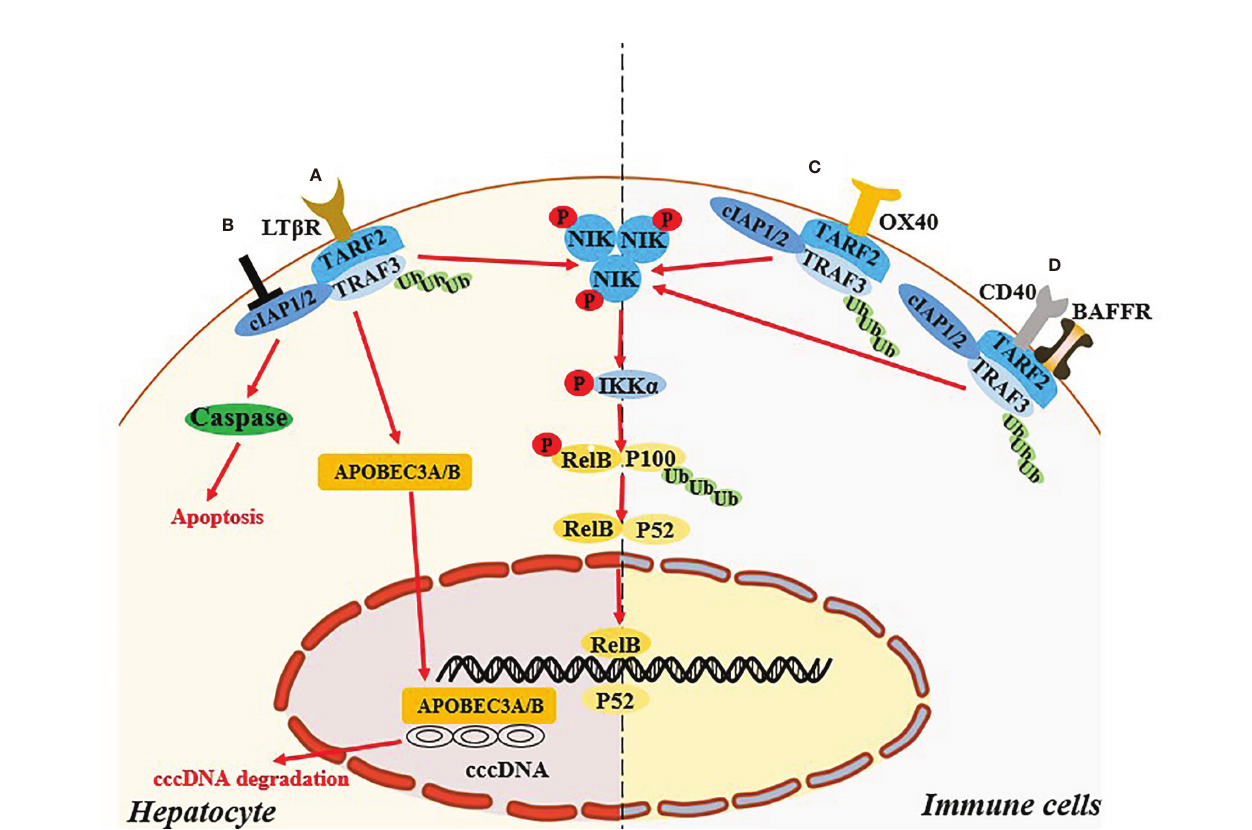
FIGURE 2 | Non-canonical NF- k B signaling pathway regulates the HBV infection. (A) In hepatocyte, activation of LTB receptor in hepatocyte mediates the non-canonical NF- k B signaling pathway and induce the up-regulated expression of APOBCE3A/B protein, which degrade cccDNA. (B) Targeting cIAPs also mediate the activating the NIK-dependent non-canonical NF- k B signaling pathway and exert the antiviral effect in hepatocyte via TNF-mediated death of infected cells. (C, D) Speci fi c ligation of OX40, BAFFR or CD40 in immune cells might recover the exhausted immune function during HBV infection through the activation of the NIK-dependent non-canonical NF- k B signaling